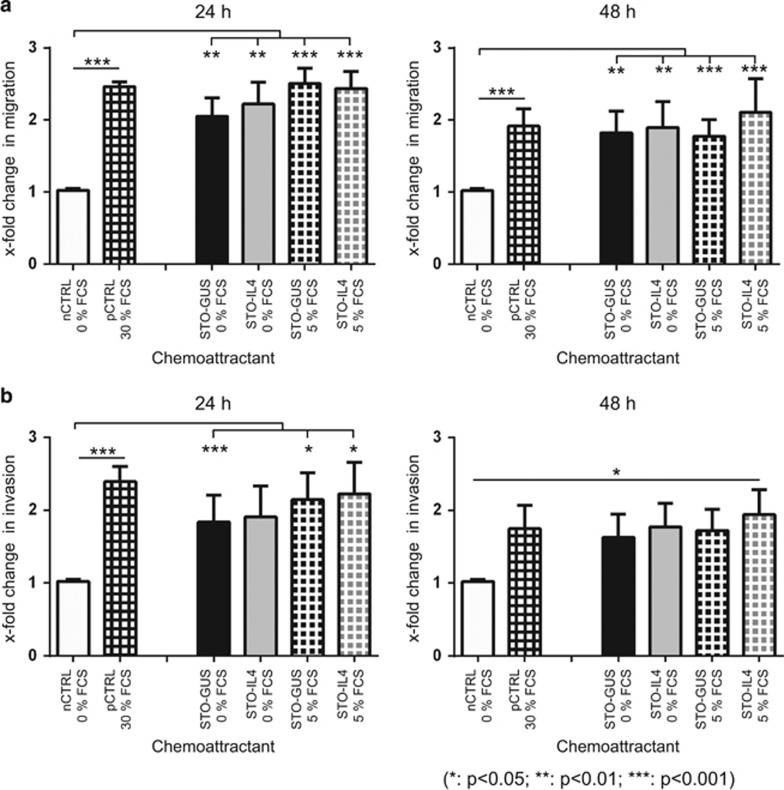
IL-4 does not influence the migration or invasion potential of primary PCa cells. (a) Fold change in migration of primary cancer cells after 24  and 48 h incubation compared to controls (n=4). Keratinocyte-serum free medium (KSFM) without added supplements served as a negative control for migration (nCTRL 0% FCS). KSFM supplemented with 30% FCS served as positive control (pCTRL 30% FCS; *P<0.05; **P<0.01; ***P<0.001). (b) Fold change in invasion through matrigel of primary PCa cells after 24  and 48 h incubation compared to controls (n=4). KSFM without added supplements served as a negative control for invasion (nCTRL 0% FCS). KSFM supplemented with 30% FCS served as positive control (pCTRL 30% FCS; *P<0.05; **P<0.01; ***P<0.001). nCTRL, negative Control, pCTRL, positive Control.